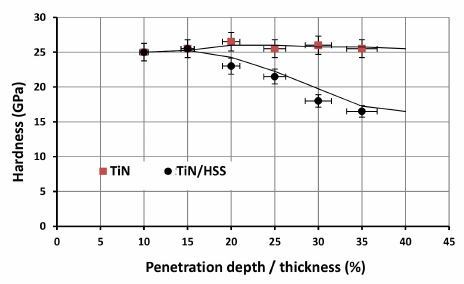
Figure 8. Comparison the hardness between bulk TiN and TiN/HCC as a function of the ratio